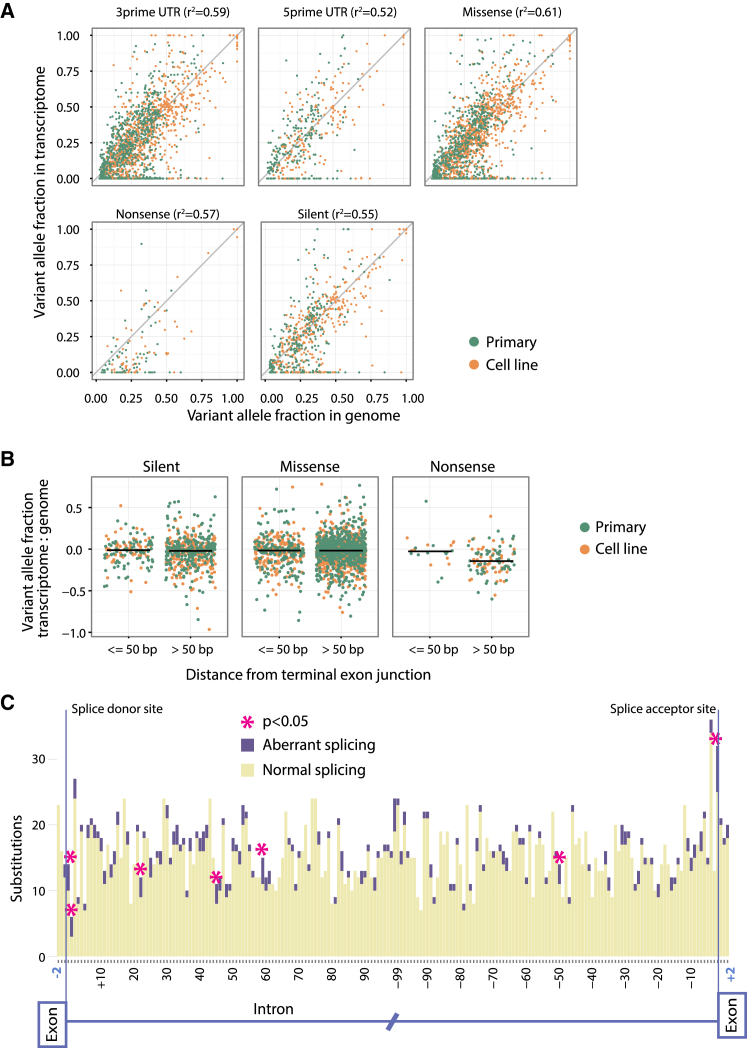
The Effect of Somatic Point Mutations on Expression and Aberrant Splicing(A) Comparison of the variant allele fractions in the transcriptome to the genome, for all classes of point mutation. The squared correlation coefficient between the genome and transcriptome is in parentheses. Only expressed coding changes are shown (five or more times coverage).(B) Variant allele fractions in the transcriptome relative to the genome. Nonsense mutations >50 bp from the terminal 3′ exon-intron junction are the only variants to show a significant difference.(C) Positional effect of mutations on aberrant splicing is shown.